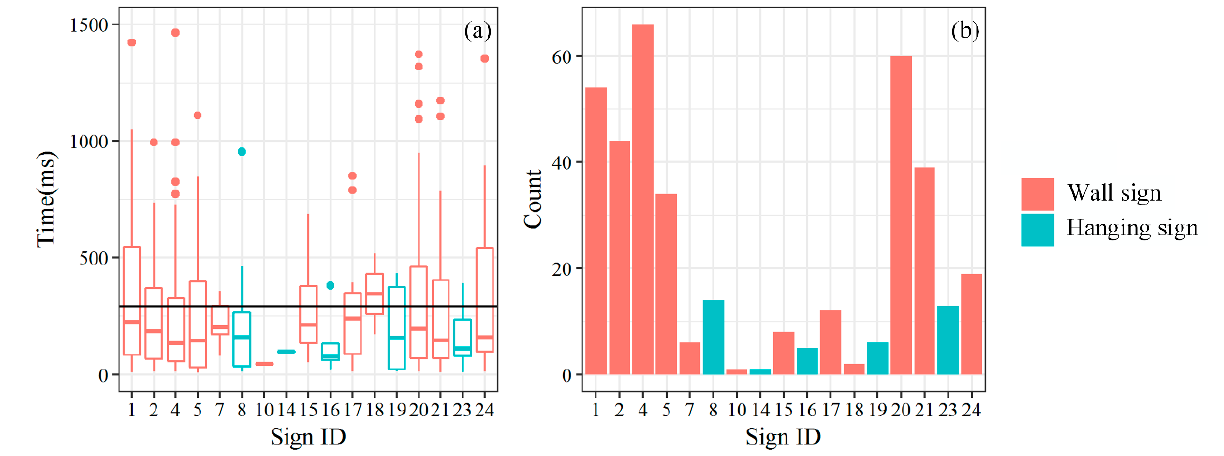
Figure 10. Perception times ( a ) and frequencies ( b ) of evacuation signs. Figure 11 takes 5 degrees as an interval for calculating the horizontal and vertical angles between evacuees and evacuation signs when the signs are perceived. Figure 11a shows a statistical histogram of the horizontal angles. We assumed that the horizontal angle meant no difference no matter the people on the left of the sign (negative angle) or on the right of the sign (positive angle). Thus, the absolute values are shown in Figure 11. In general, the perception frequency decreased with increasing horizontal angle. However, two peaks appeared near 45 ◦ and 75 ◦ . The data of the two peaks occurred mostly on signs 2, 4, and 5. On the one hand, these signs were near decision points, which means that the participants could observe the sign across the decision point from the other road at certain angles. On the other hand, these signs were on the major evacuation path starting from P1, which means that the observation frequency was high. Thus, these certain angles became two peaks. Note that the wall signs were perceived in a wide angle range, while the hanging signs were perceived at a low angle. This could indicate that wall signs are easier to observe from different angles than hanging signs. Figure 11b shows a statistical histogram of the vertical angles. Because hanging signs are usually higher than eye level, while wall signs are usually lower than eye level, and the vertical angles of the two types of signs were distributed in two completely different regions. We believed that the intervals with too few observations were not statistically significant. Therefore, all intervals with fewer than five perceptions were excluded. According to statistics, the range of the horizontal angle was [0 ◦ , 85 ◦ ], the vertical angle range of the hanging signs was [15 ◦ , 30 ◦ ], and the vertical angle range of the wall signs was [ − 50 ◦ , − 10 ◦ ].